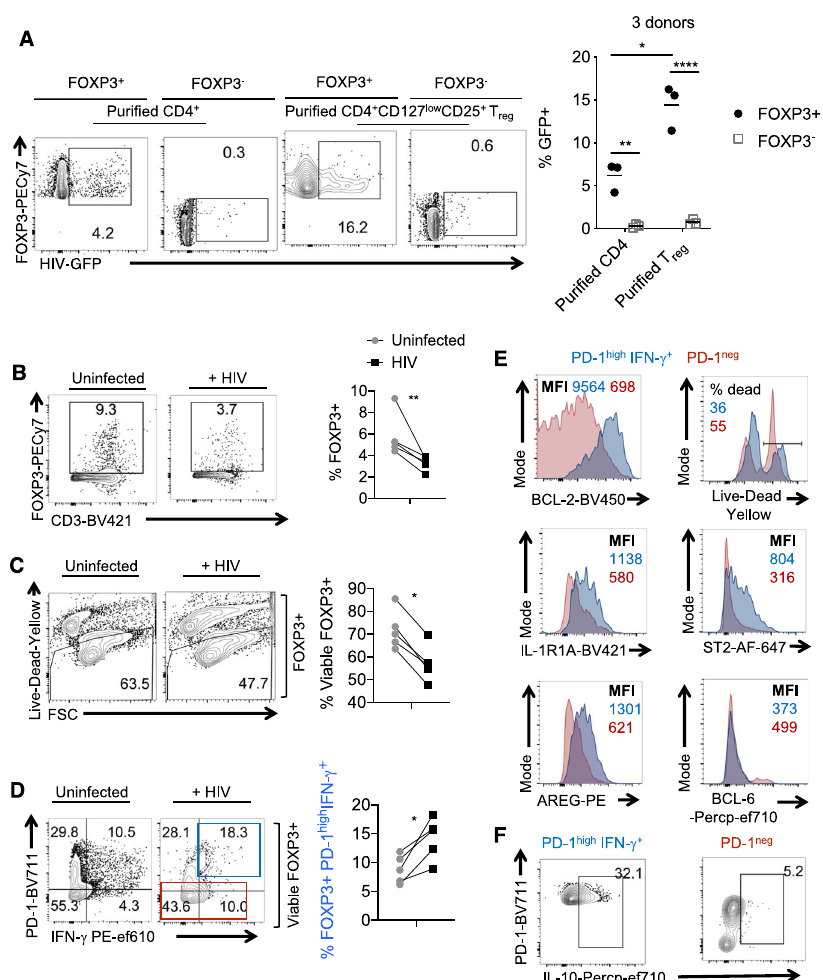
(~91% purity) or CD4 + CD25 + CD127 low T reg cells (>88% FOXP3 + ) were TCR activated and infected with HIV as described in “ Methods. ” GFP was assessed in FOXP3 + (left) or FOXP3 − (right; gated on Foxp3 neg cells) fractions 48 h post-infection. Representative fl ow cytometric data (left) and statistical analyses from three independent tonsil donors (right) are shown. Mean + / − SEM are shown; * P < 0.05; **<0.005, ****<0.00005; two-tailed; cytometric analyses of CD3 + FOXP3 + cells pre-gated on CD8 − cells ( B ), viability of CD3 + CD8 − FOXP3 + cells ( C ), PD-1 and IFN- γ expression in viable CD3 + FOXP3 + CD8 − cells ( D ), with respective statistical analyses (right) are shown. B – D n = 5; * P < 0.05; ** P = 0.007; two-tailed; Mann – Whitney test. E , F Flow cytometric plots showing the expression of the indicated proteins in PD-1 high and PD-1 low populations gated in D in HIV-infected HTC. B – F Five independent experiments showed similar